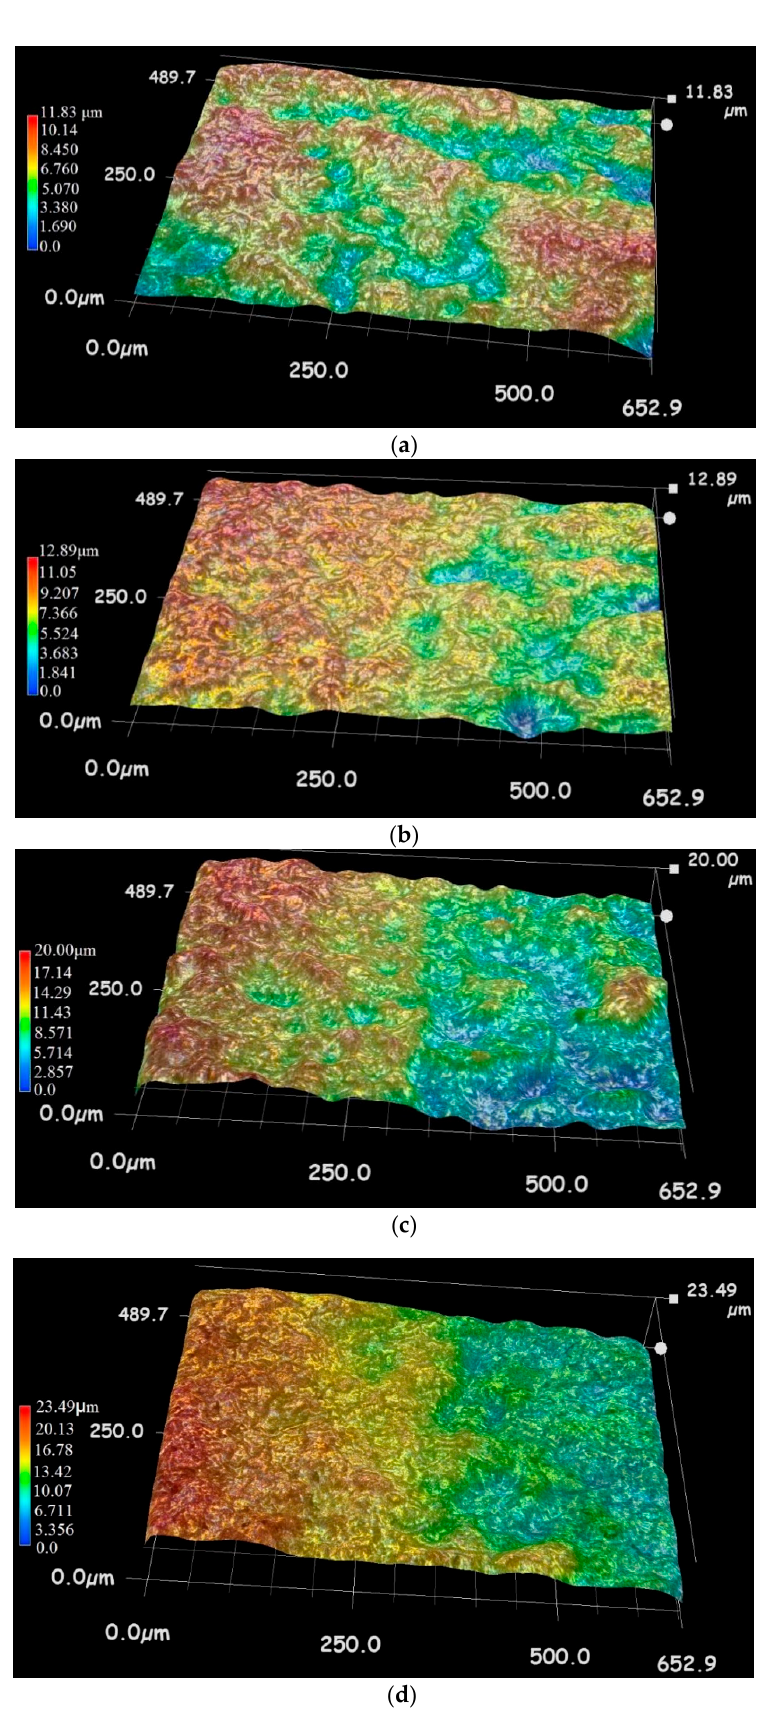
Figure 10. Influence of three-step heating methods on 3D surface topography of the Al–Si coating boron steel sheet of ( a ) Scheme A, ( b ) Scheme B, ( c ) Scheme C, and ( d ) Scheme Table 6. Density values of the common Fe x Al y Si z intermetallic compounds [27]. Intermetallic Compounds